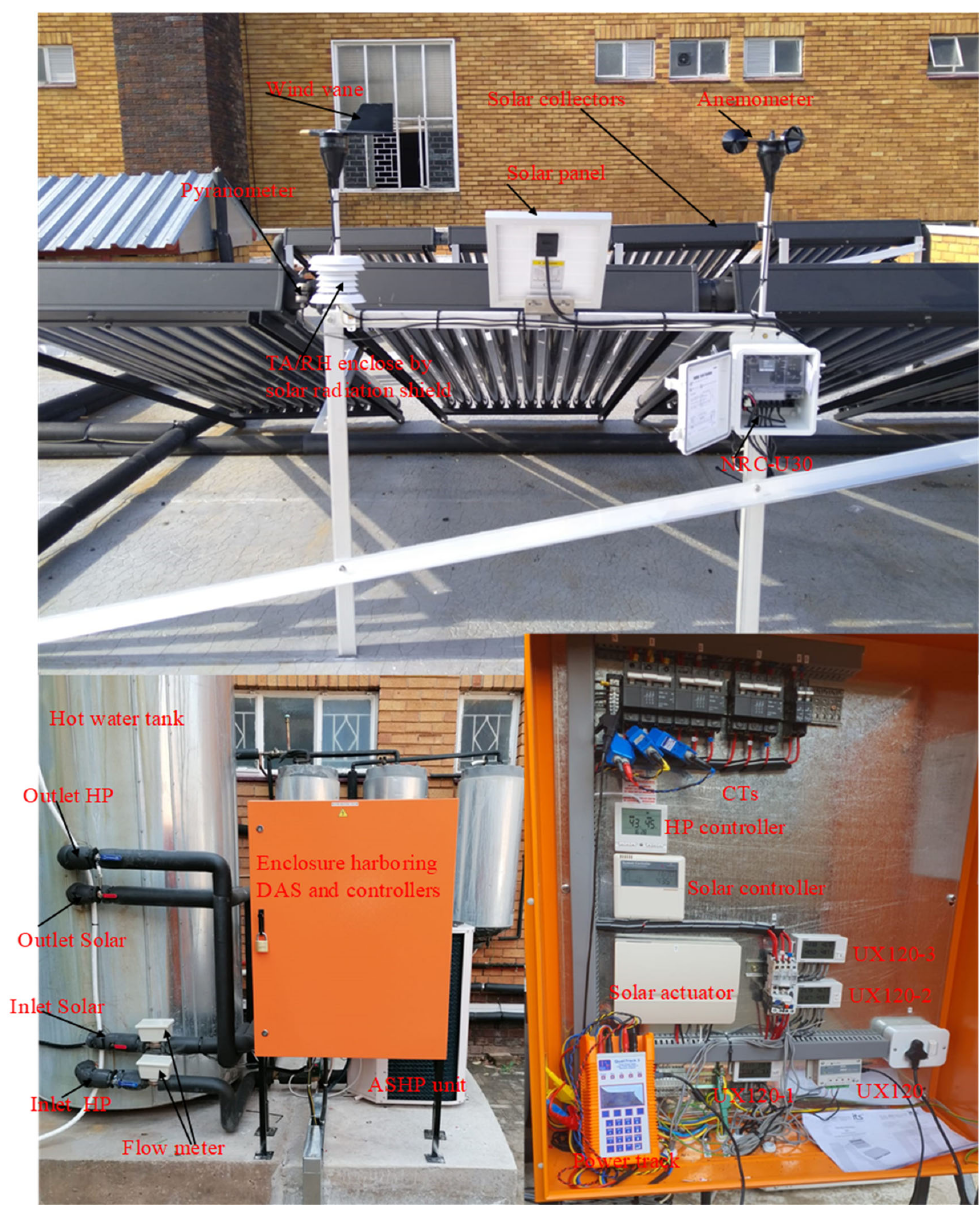
Figure 6. Installed DX-SAHP water heater and